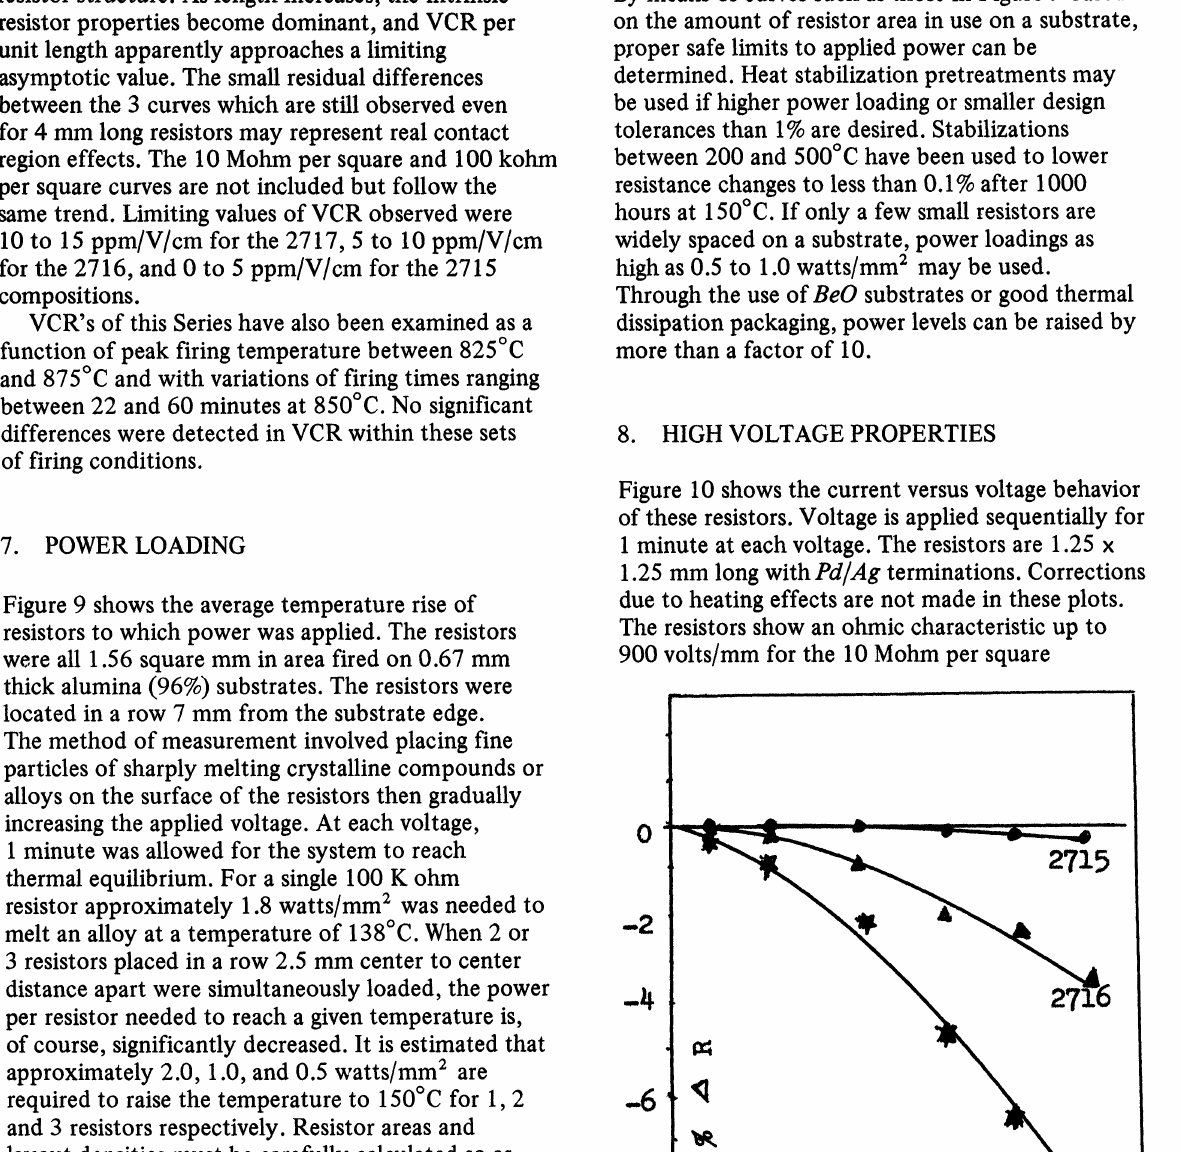
Voltage step stress